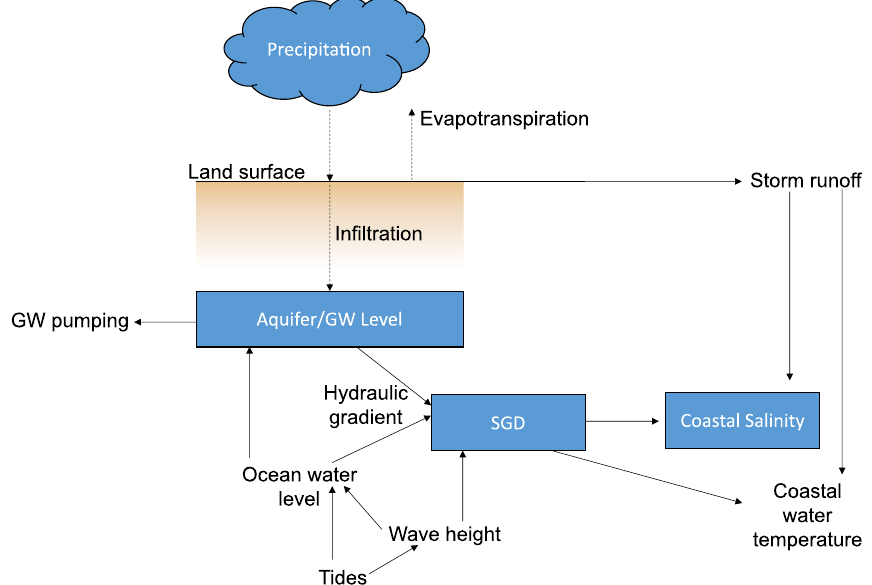
Figure 1. Conceptual flowchart of processes impacting parameters of interest (indicated in blue boxes – coastal salinity, SGD, and groundwater level). The three parameters analyzed were selected because of their direct and environmentally relevant relationships. Ecosystems are greatly dependent on coastal salinity (parameter 1), which at the study site is driven mostly by SGD (parameter 2) and ocean processes. SGD therefore plays an essential ecological role. Groundwater (parameter 3) is the ultimate source of fresh meteoric groundwater in SGD. Additionally, we must acknowledge that marine drivers are also moderating SGD. Tides are not included as a parameter of interest since tides are predictable and instead are used as an explanatory